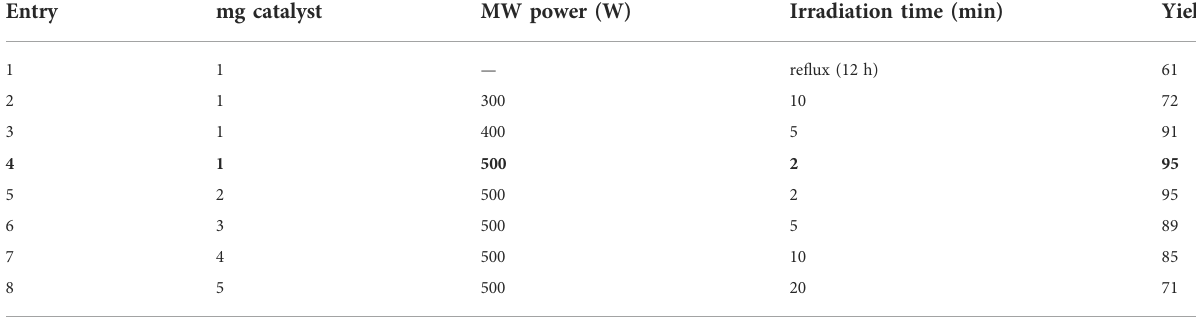
That the bold values indicates the selection of optimal conditions. The optimal conditions: 1 mg of catalyst (CCPSF NPs) and power of microwave irradiation of 500 W for 2 min were